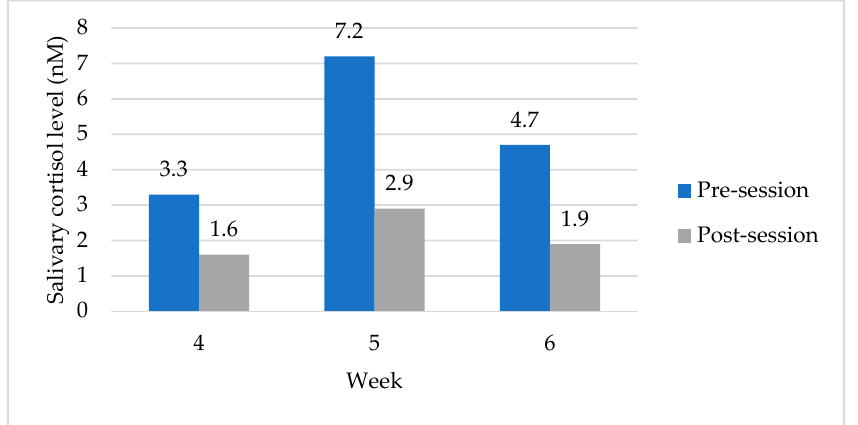
Figure 5. Pre- and post-session salivary cortisol samples ( n = 17). Paired-Sample t-Tests Pre- and Post-Program The mean scores for salivary cortisol levels pre-session for week 4 (M= 3.44, SD= 1.36) and post-session (M = 1.56, SD = 0.65) conditions, t (14) = 6.3, p = 0.001) suggest a significant decrease in salivary cortisol levels pre- and post-session. The difference in mean scores ( x d = 1.88, s d = 1.14) indicated a large effect size ( d = 1.64) [96] and suggested that the post-session cortisol level was over 1.5 standard deviations lower than the pre-session cortisol level. Similarly, week 5 pre-session (M = 7.1, SD = 4.8) and post-session (M = 2.7, SD = 2.45), t (14)= 4.3, p = 0.001, and week 6 pre-session (M = 4.4; SD = 2.6) and post-session (M = 1.8; SD: 0.66), t (16) = 4.2, p = 0.001, suggesting a significant decrease in salivary cortisol levels pre- and post-session. The difference in mean scores for week 5 ( x d = 4.46, s d = 3.94) and week 6 ( x d = 2.6, s d = 2.54) produced a large effect size (week 5 d = 1.13; week 6 d = 1.02) indicating the post-session cortisol levels were over one standard deviation lower than the pre-session levels.